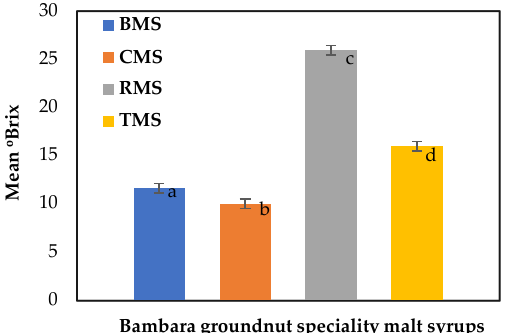
Figure 6. Degree Brix of Bambara speciality malt syrups. Values are the mean of triplicates ± standard deviation; mean values on the bars with different letters are significantly different ( p < 0.05).